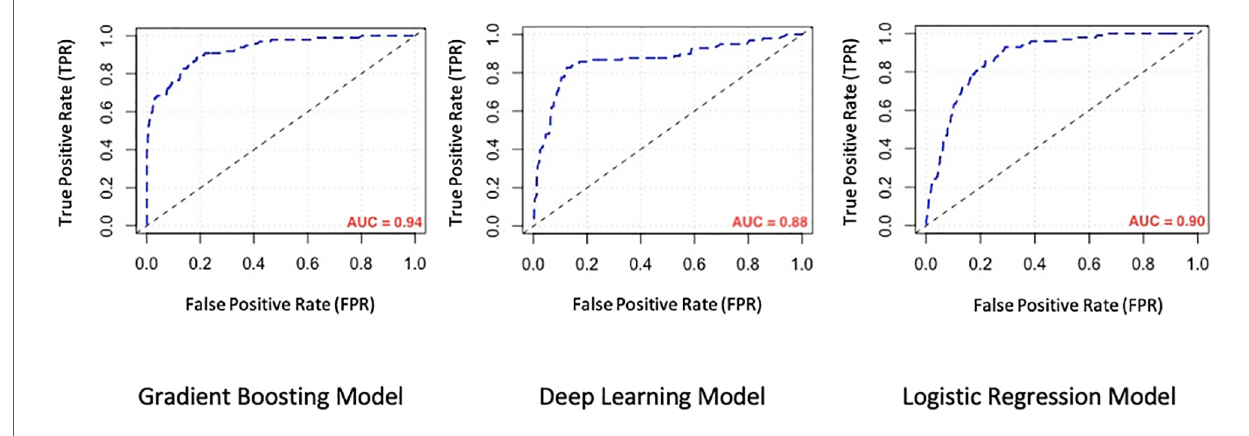
FIGURE 1 Comparison of the receiver operating characteristic curve (ROC curve) of machine learning models. AUC, area under the